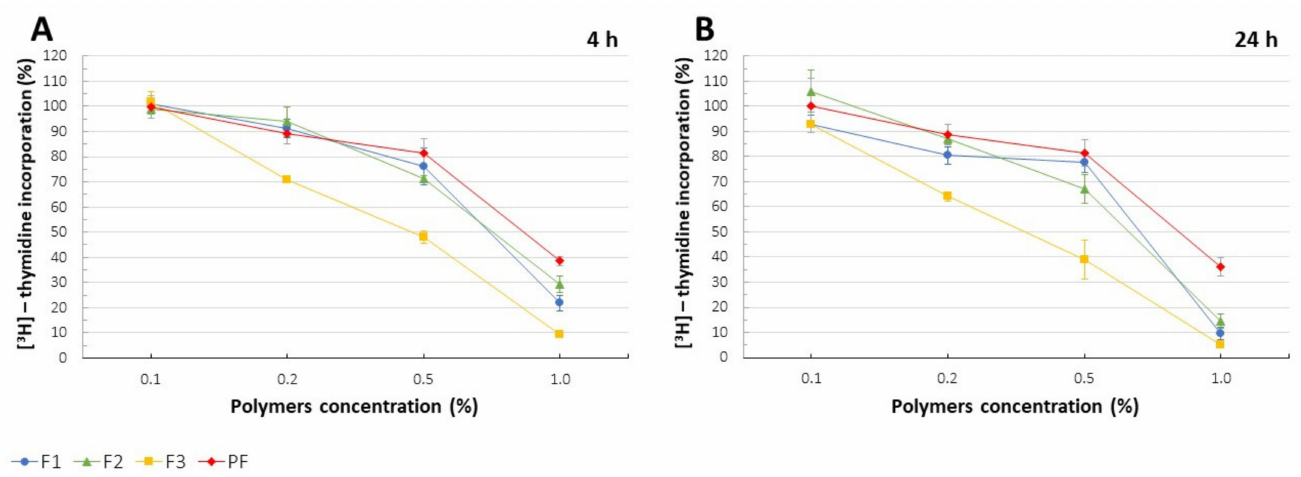
Figure 8. [3H]-thymidine incorporation (%) recorded for F1–F3 and placebo films (PF) after 4h ( A ) and 24 h ( B ) (mean ± SD, n = 4, p <